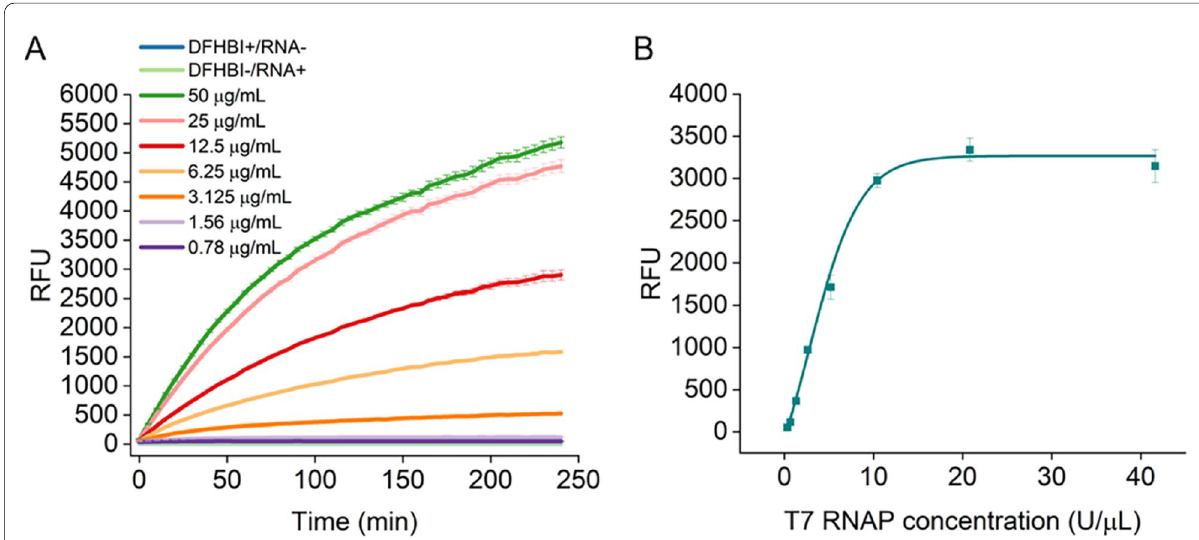
Fig. 5 Application of STAR in characterizing the activity of T7 RNAP. A Real‑time determination of relative fluorescence unit produced by STAR under different concentrations of T7 RNAP. B Real‑time determination of relative fluorescence unit produced by STAR under different concentrations of commercial T7 RNAP. Error bars represent the standard deviation of the triplicate